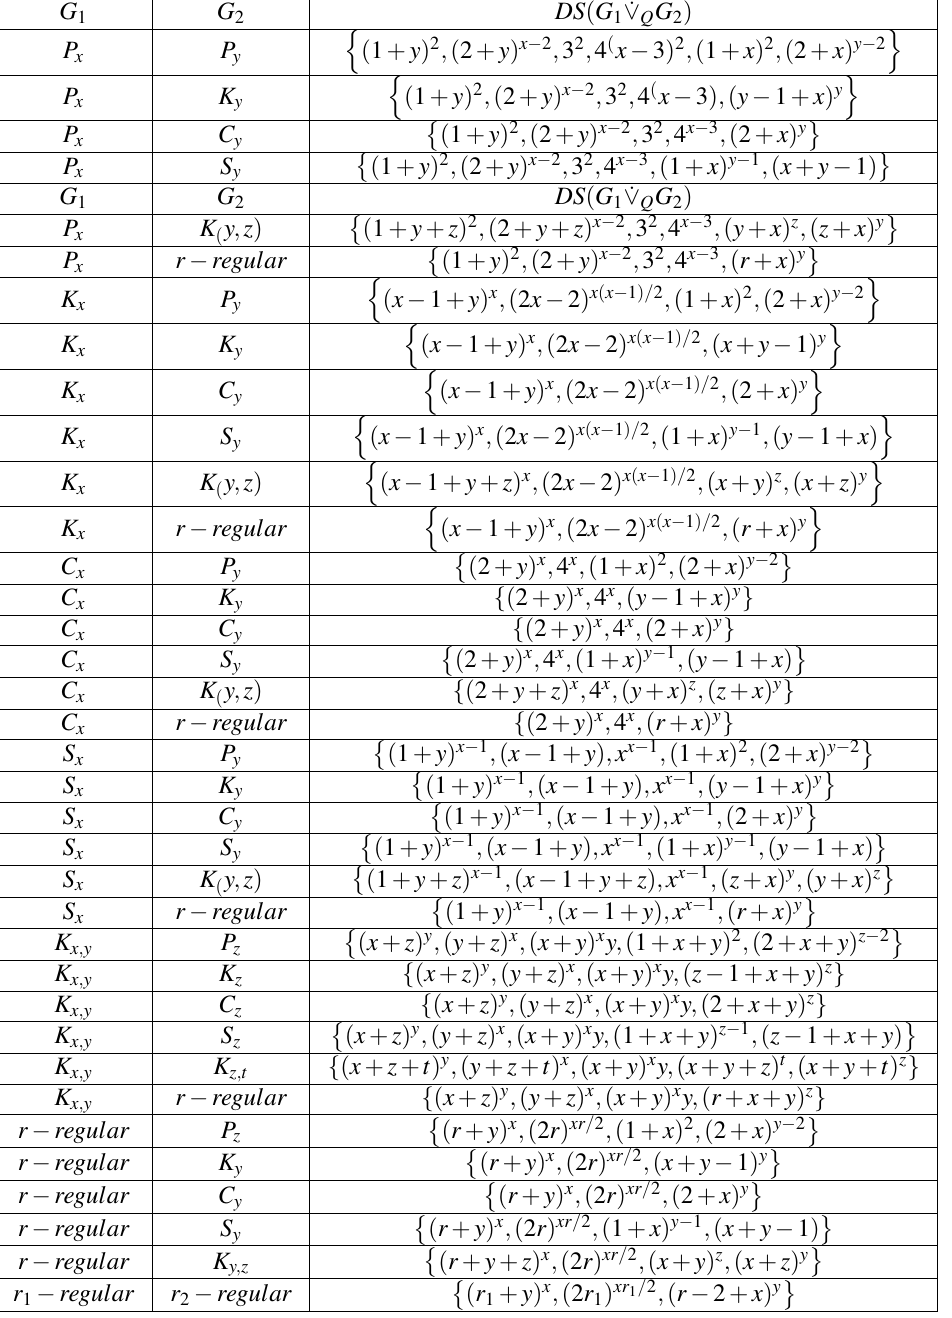
Table 4 Degree Sequence of vertex- Q join graph for path, complete graph, cycle, star, complete bipartite and r − regular